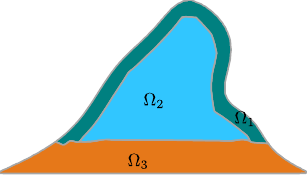
Fig. 11 Subdomains for heterogeneous biofilm model